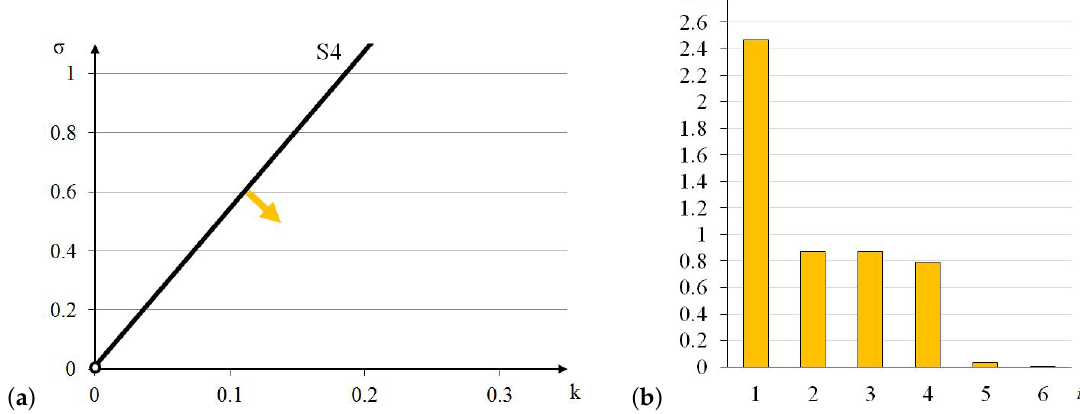
Figure 5. Extreme properties of the 4-strut simplex: ( a ) Line of extreme properties σ = 0.012 + 5.34 · k . ( b ) Distribution of eigenvalues for k = 0.1, σ = 0.546 (multiplier EA / a 2